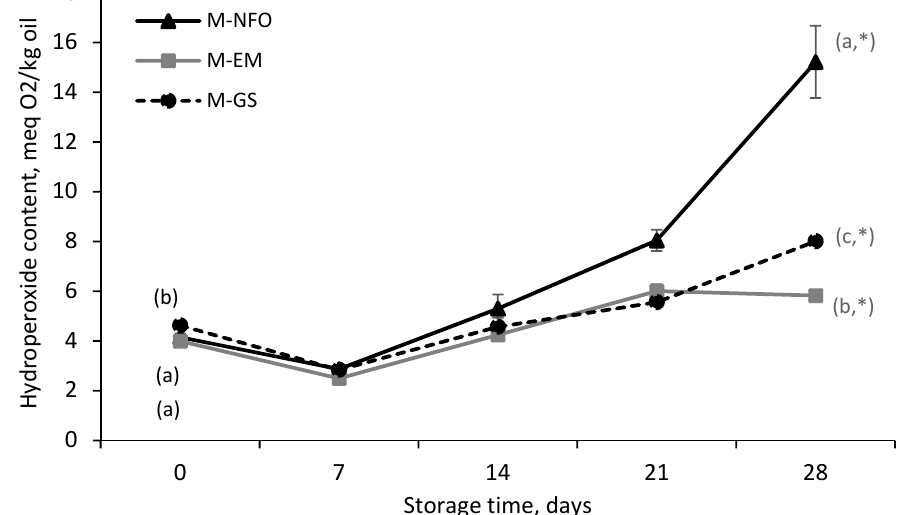
Figure 5. Peroxide value (PV) of low ‐ fat fortified mayonnaise enriched with neat fish oil (M ‐ NFO), emulsified fish oil (M ‐ EM) or microencapsulated fish oil (M ‐ GS) over storage time at 25 °C. Means within the same sampling point followed by a letter, a ‐ c, indicates statistical differences ( p ≤ 0.05). Means within the same sample followed by an asterisk (*) indicates statistical differences ( p ≤ 0.05) between day 0 and day 28.